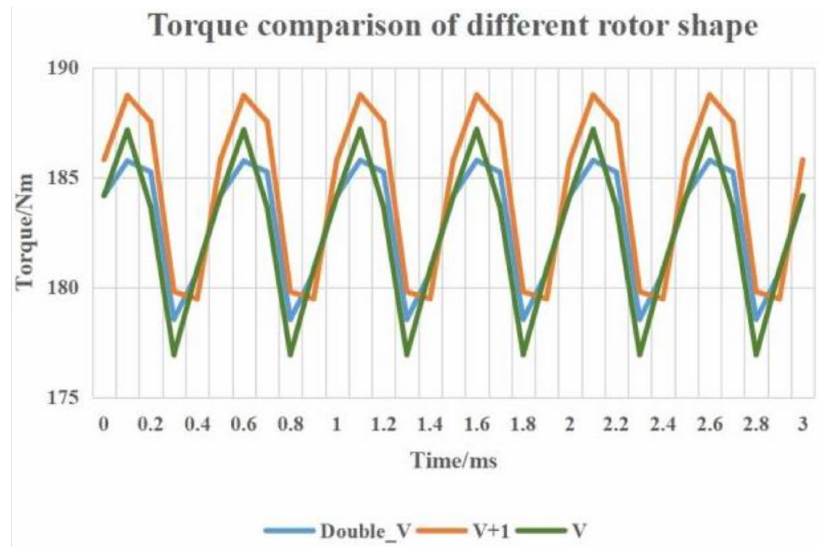
Figure 7. Torque of different rotor shapes. Table 5. Summary of different performance parameters.